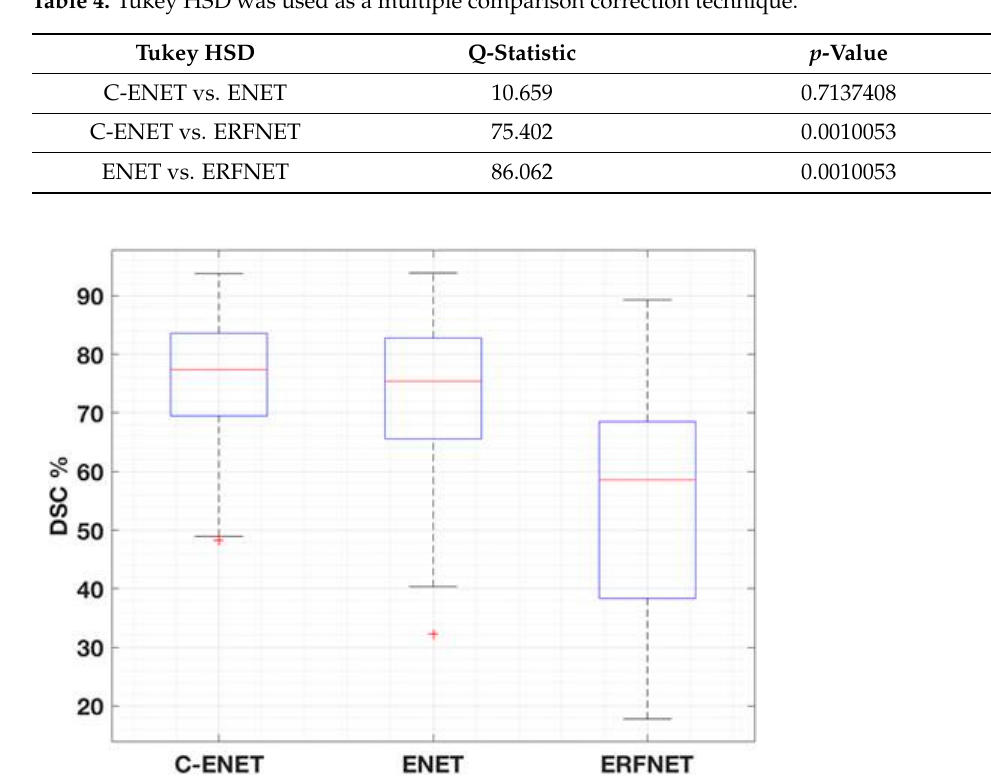
Figure 3. DSC-based boxplots of the different DL networks.